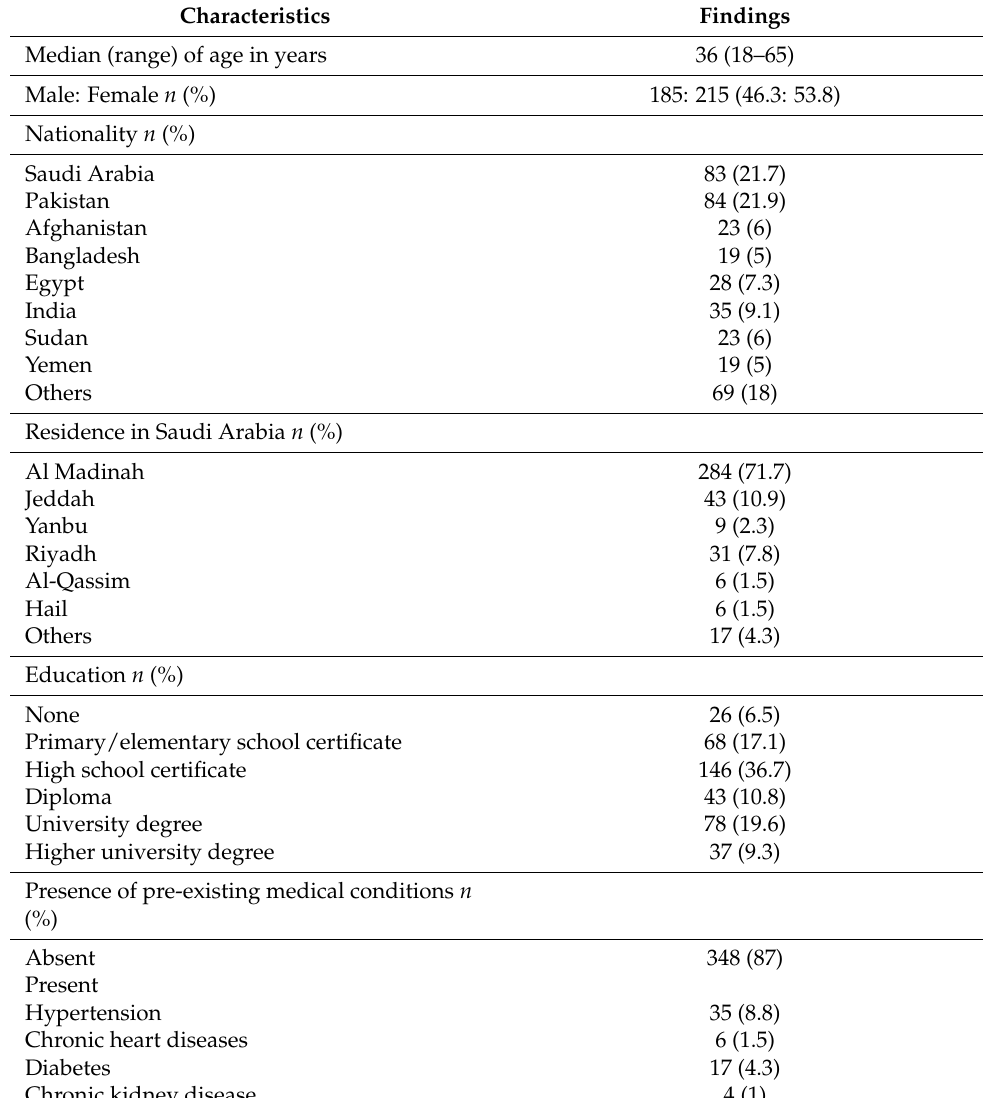
Table 1. Demographic characteristics of respondents ( n = 400). Characteristics